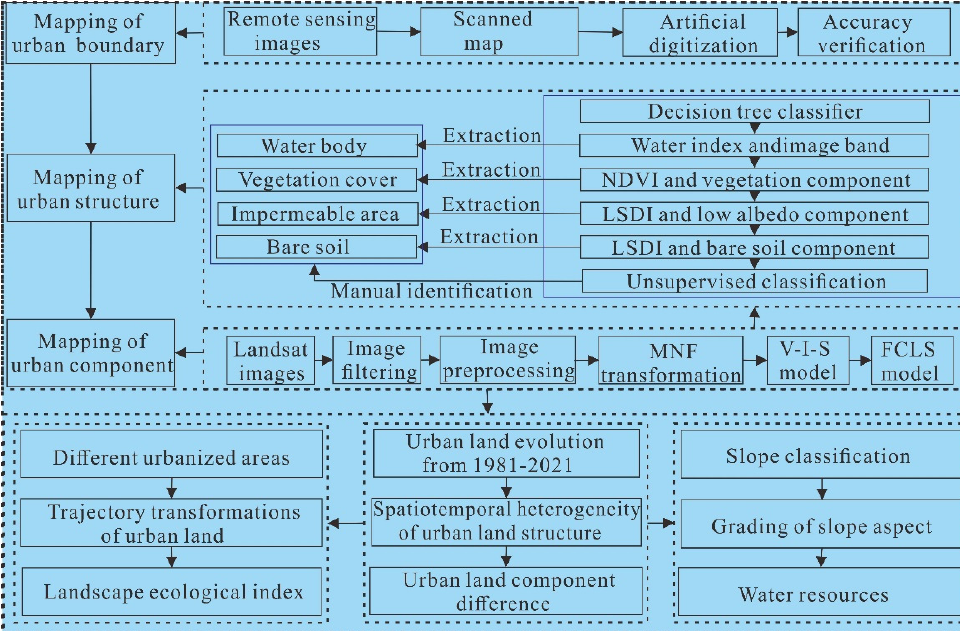
Figure 2. The workflow of the study area.